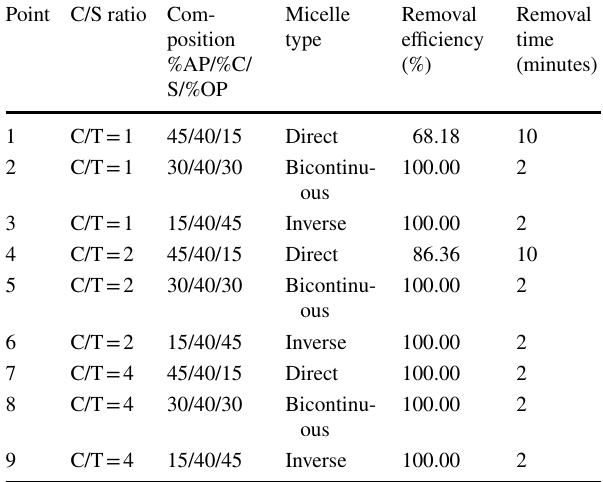
Table 1 Formulations and removal efficiencies for the flushing fluids Point C/S ratio Com-